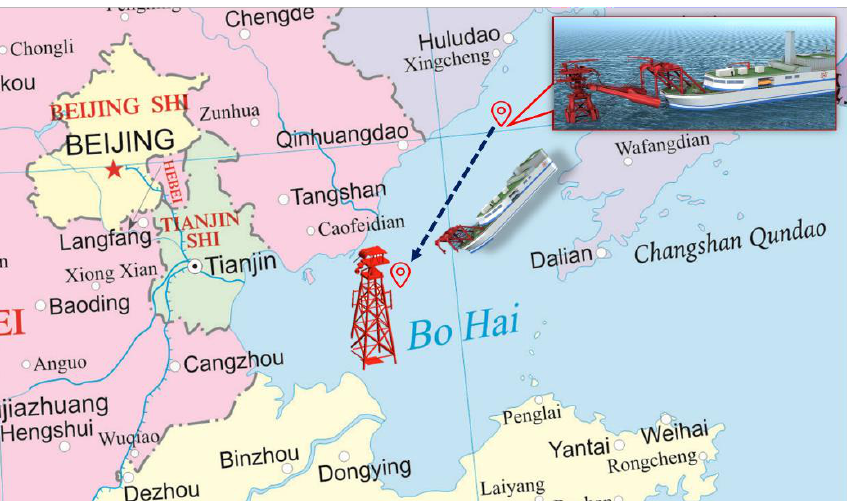
Figure 1. MNPP replacement operation sea area.